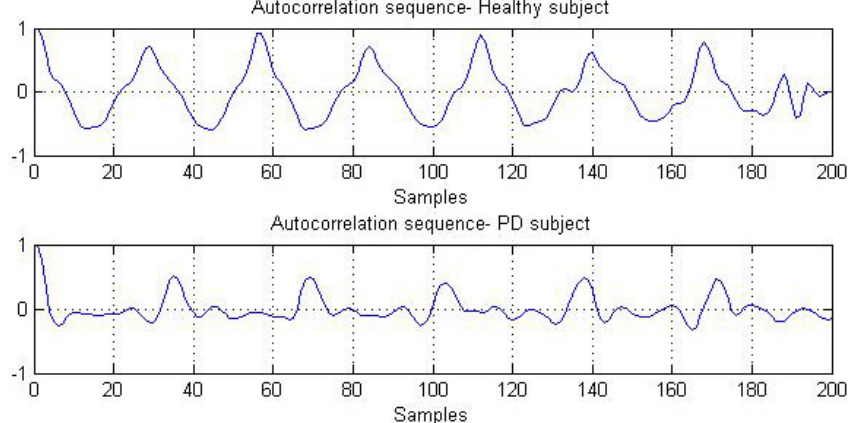
Figure 3. The example of autocorrelation sequences (VT acceleration) computed from a young healthy subject (above) and a PD patient